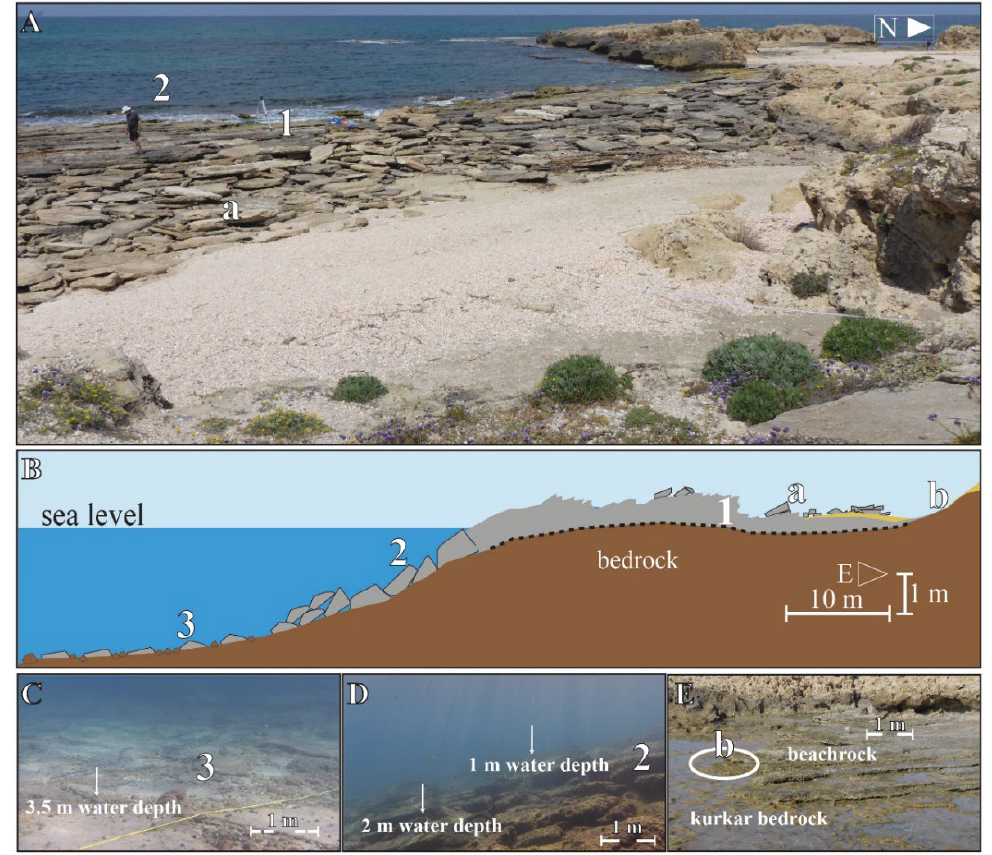
Figure 7. Beachrock exposure at Beachrock Cove site, north of Dor: ( A ) view of the site ( 1 : BR outcrop; 2 : broken BR slabs at sea side, ( a ) BR slabs scattered on shore); ( B ) schematic cross-section of the site (VE = 4, 3 : BR plates paving seafloor at about 3.5 water depth, ( b ) BR: bedrock contact backshore, dotted line marks uncertain unit contact depth, other notes are as in ( A )); ( C ) close-up (looking south-west) of BR exposure sea side edge ( 3 : as in ( B )); ( D ) close-up (looking north) of BR exposure sea side of the BR outcrop ( 2 : as in ( A , B )); ( E ) close-up (looking south-west) of BR–bedrock contact backshore (( b ) as in ( B